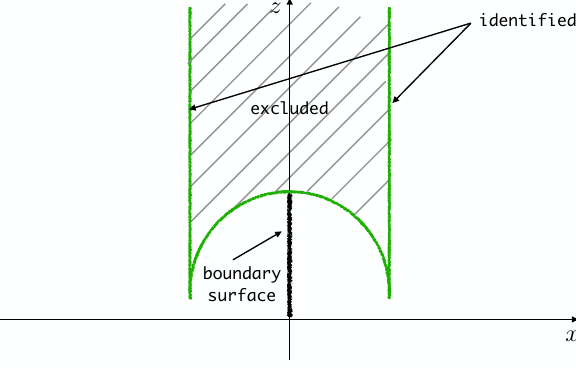
Figure 40 . A time slice t = const. in a single splitting quench. The green curve is an identi(cid:12)cation surface whose + x part and x part should be identi(cid:12)ed to realize the true bulk geometry. The (cid:0) shaded part is excluded. The thick black line is the boundary surface, which extends from the quench point and falls towards + z direction. Essentially, there is a falling boundary surface extending from the quench point and other parts of the bulk are